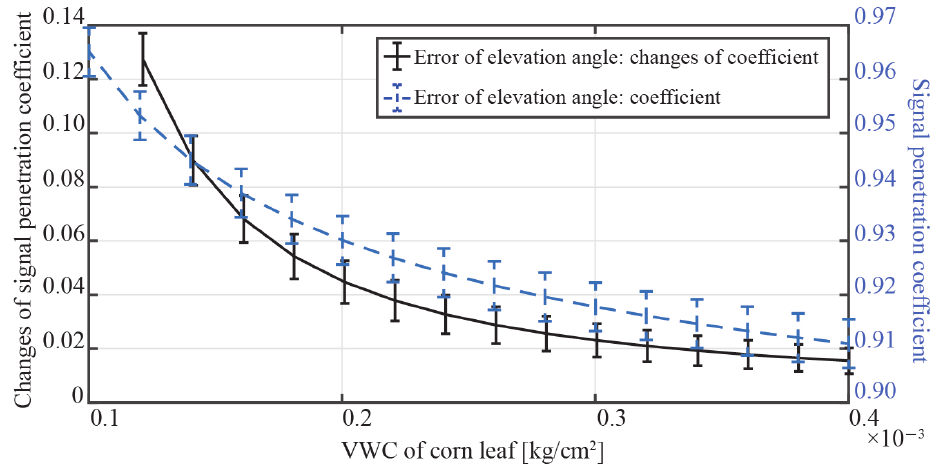
Figure 3. Changes in the electromagnetic wave power attenuation coefficient as a result of variations in the satellite elevation angle and the corn leaf’s